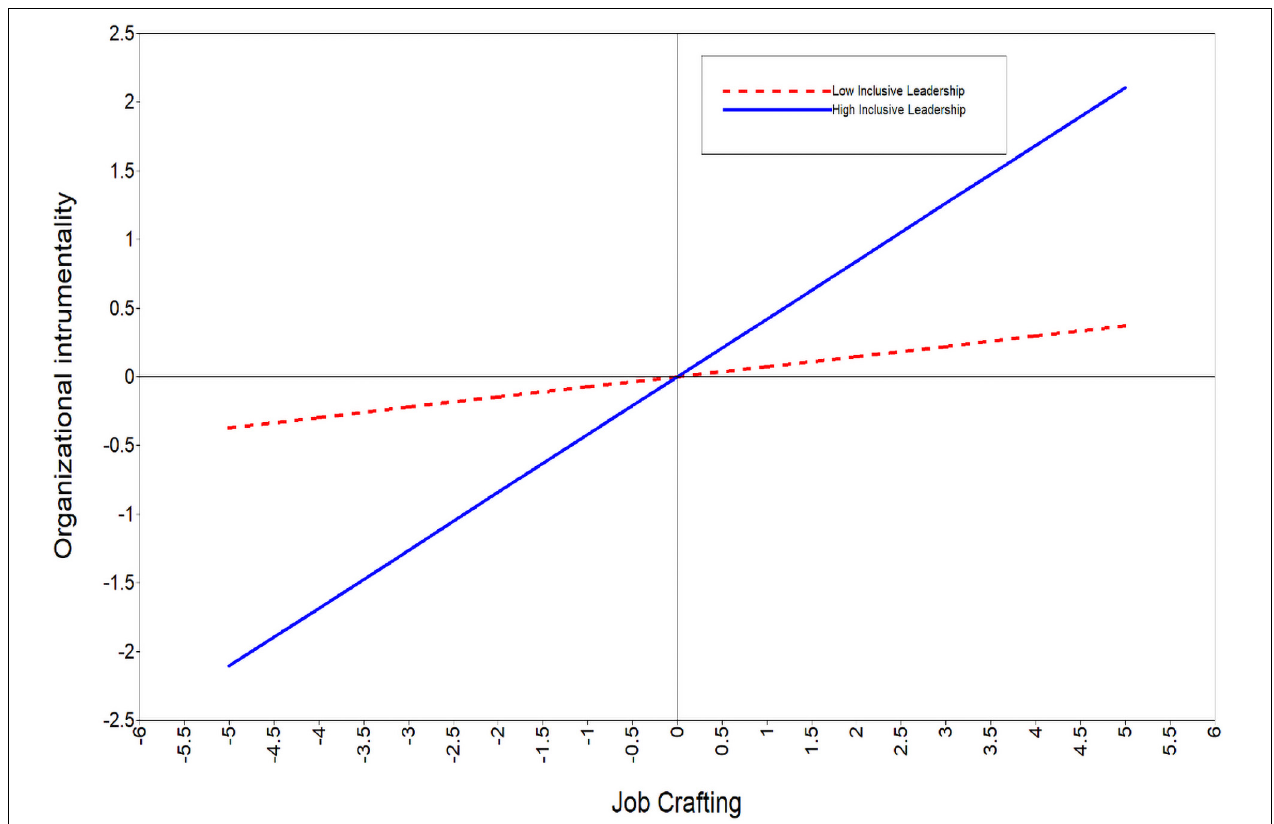
FIGURE 3 | The moderation effect of inclusive leadership on the relationship between job crafting and organizational instrumentality.